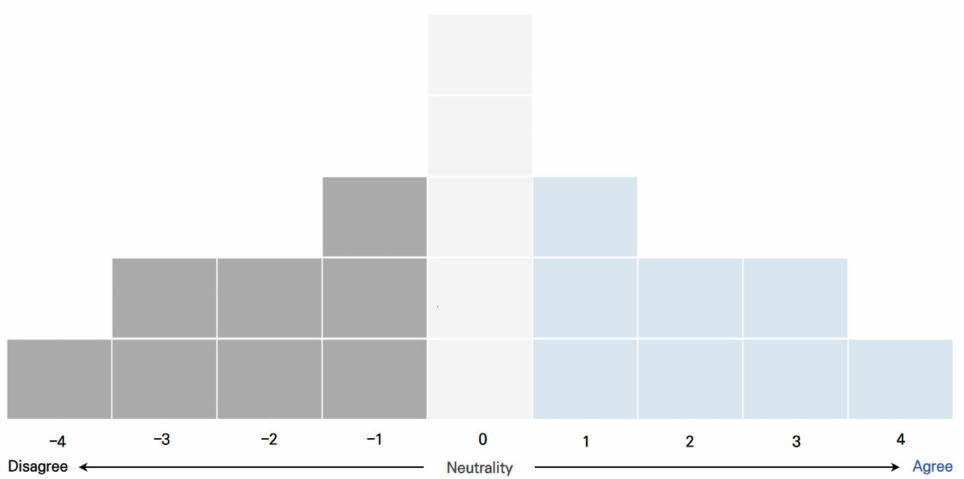
Figure 2. Q sorting.